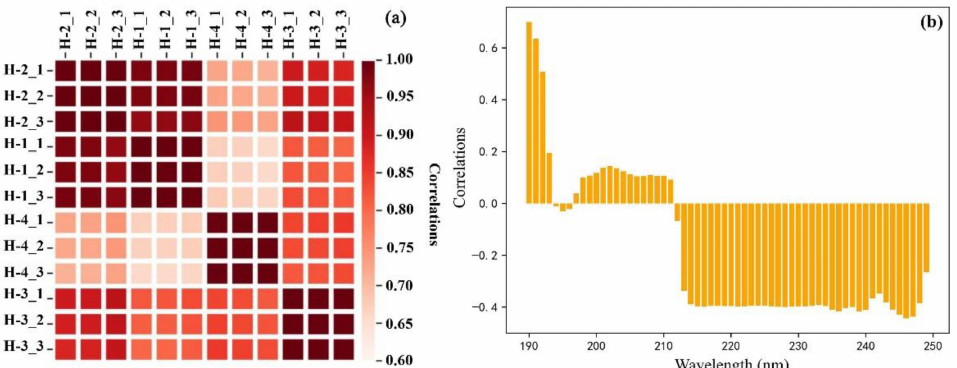
Figure 7. ( a ) Pearson’s correlation coefficient between each aquifer after treatment, ( b ) Pearson’s correlation coefficient between each band and proportion after